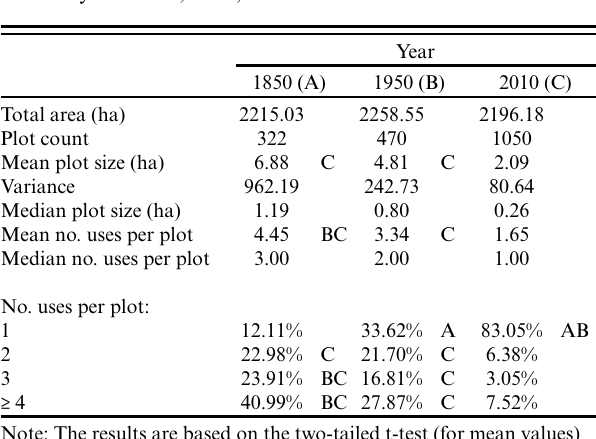
Table 4 . Basic plot data (count, size, and number of land uses) and plot distribution according to the number of reported land uses for years 1850, 1950, and